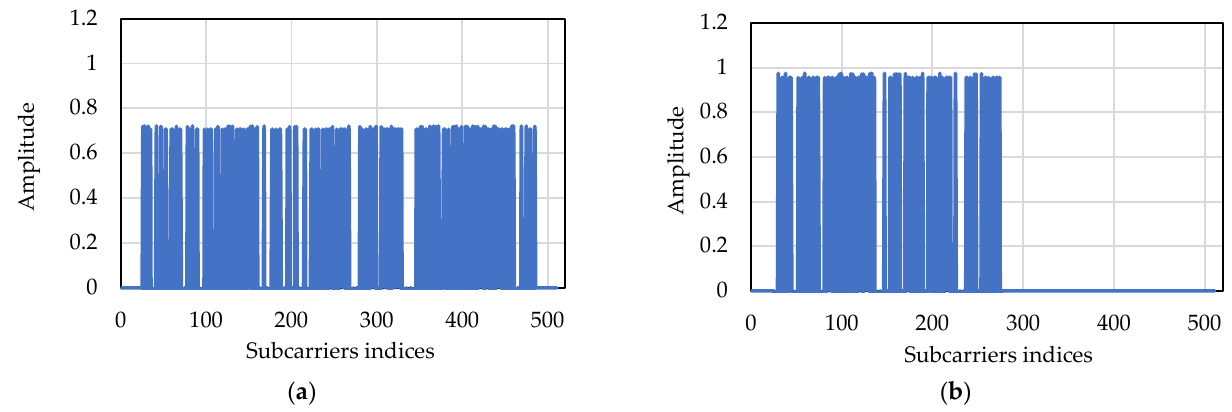
Figure 15. ( a ) Subcarrier amplitude when all clusters are active, and ( b ) subcarrier amplitude when 10 of the clusters are discarded.